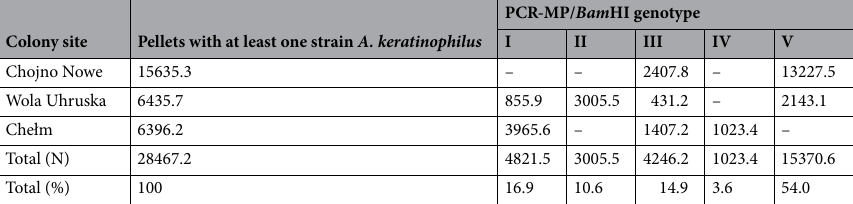
Table 3. PCR-MP/ Bam HI genotype minimal dispersion of A. keratinophilus strains originating from colony sites where > 10 strains of analysed fungi were available.